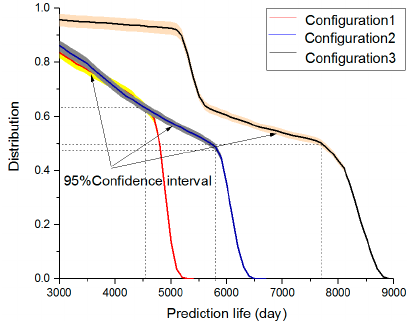
Figure 20. Life distribution with different configurations under work mode M3.